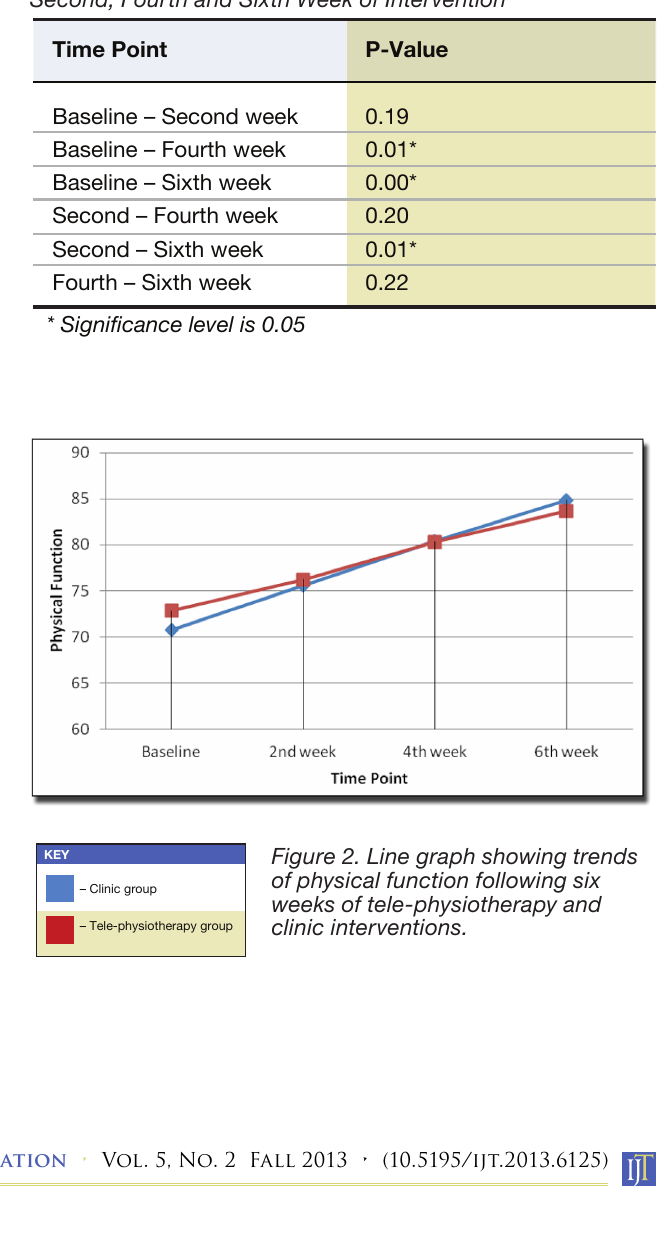
Table 9. Post Hoc Test (Least Square Difference) of Physical Function Scores in the Clinic Group across Baseline,